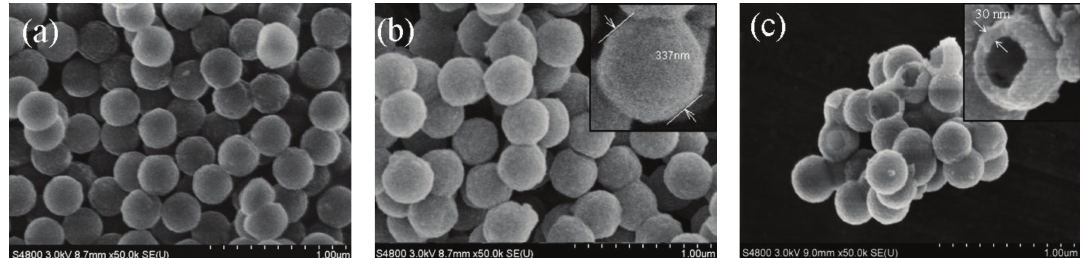
Figure 2: FESEM micrographs of (a) PS microspheres covered with Cd precursor and (b) further covered with Ti precursor before calcina- tions and (c) CdS-TiO 2 sample after calcinations.